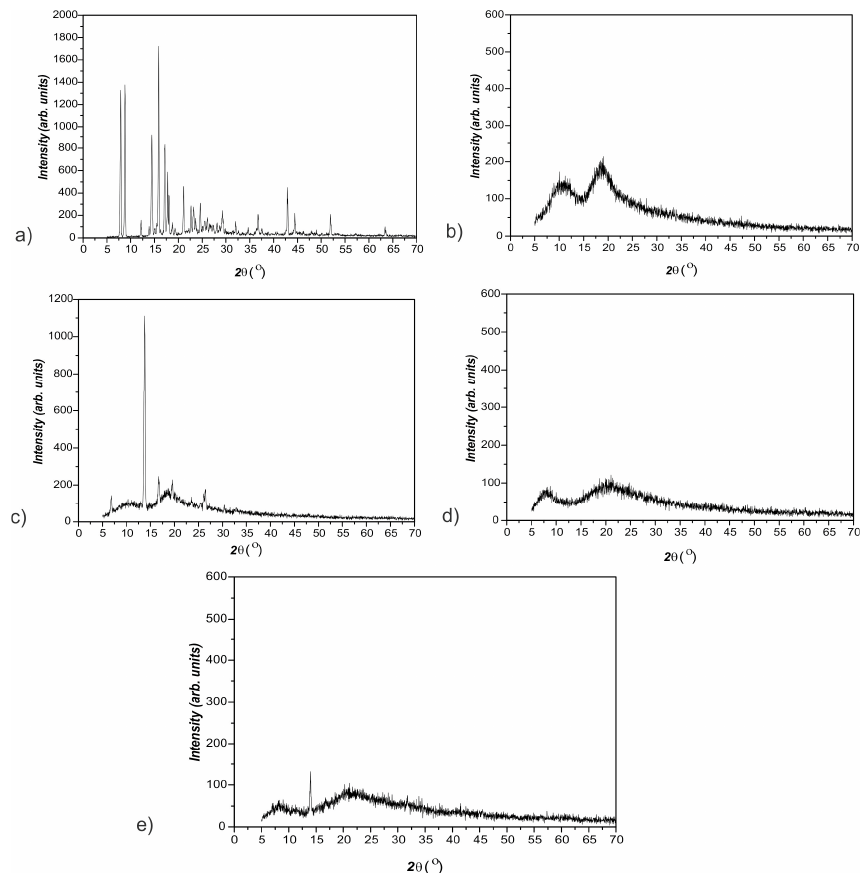
Figure 13. The XRD diffractograms: ( a ) curcumin, ( b ) 2 ‐ hydroxypropyl ‐β‐ cyclodextrin, ( c ) inclusion complex of curcumin:2 ‐ hydroxypropyl ‐β‐ cyclodextrin, ( d ) p(NiPMAm/NiPAm) hydrogel containing 2 mol% of crosslinker, and ( e ) p(NiPMAm/NiPAm) hydrogel with incorporated curcumin:2 ‐ hydroxypropyl ‐β‐ cyclodextrin complex.